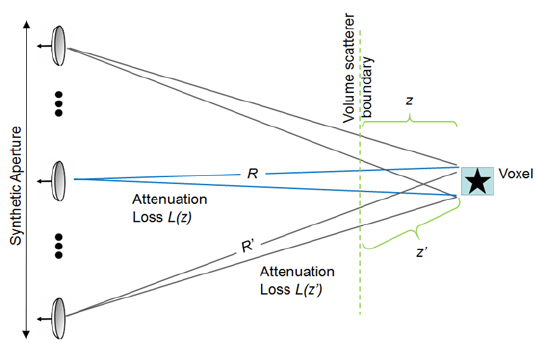
Figure 4. Signal path geometry for a 1D synthetic aperture. The path length through the vegetation (the volume scatterer region to the right of the boundary line) varies with real ‐ aperture antenna positions within the synthetic aperture, resulting in different attenuation values even when the attenuation source is considered to be uniform. For tree imaging, the attenuation varies with the path through the spatially ‐ varying vegetation density [1].